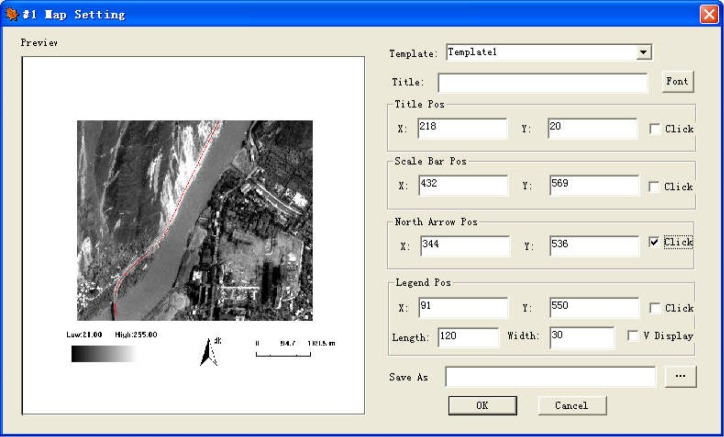
Export map dialog.